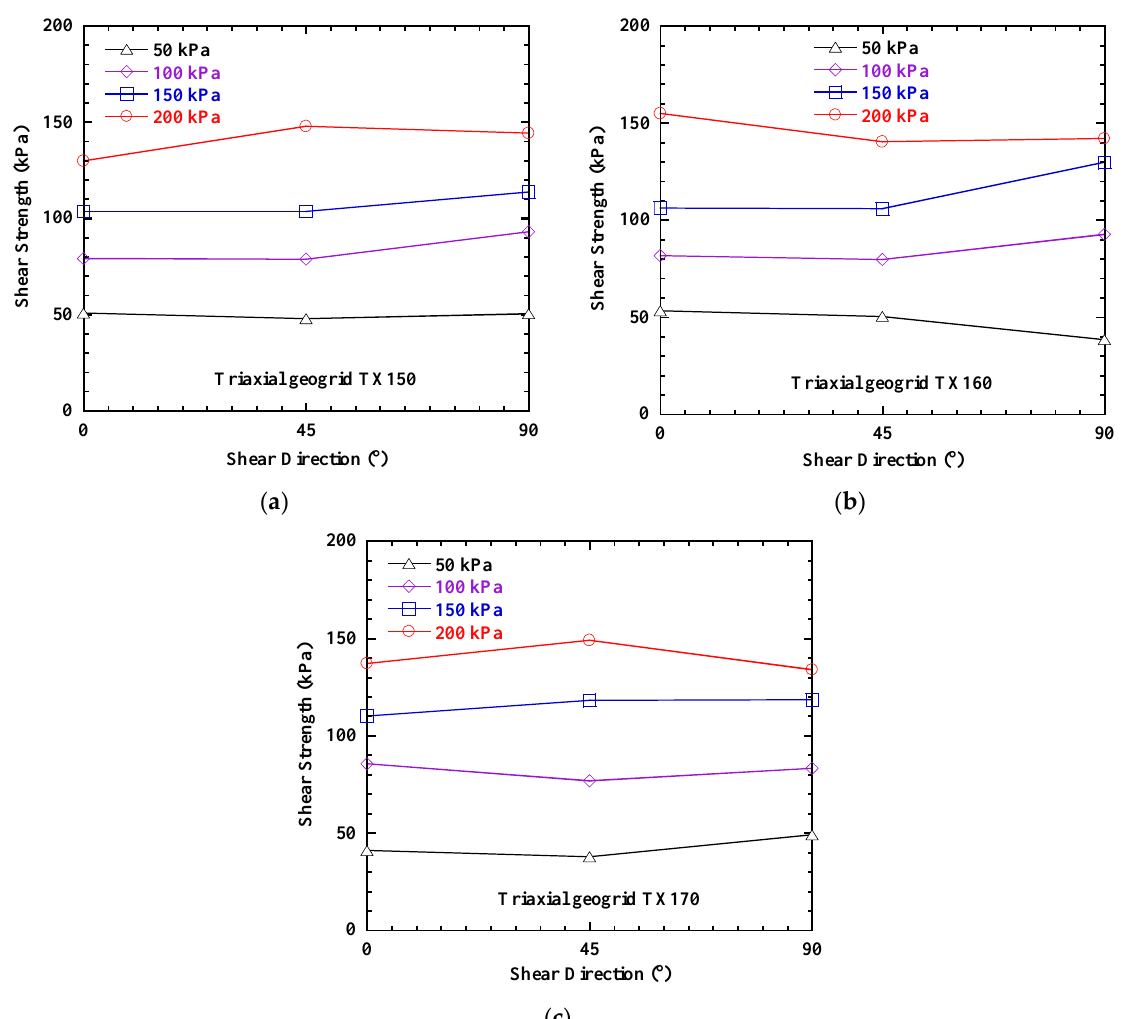
Figure 7. The influence of shear direction on the shear strength of fine sand–biaxial geogrid interfaces. ( a ) SS20, ( b ) SS30, ( c ) SS40.